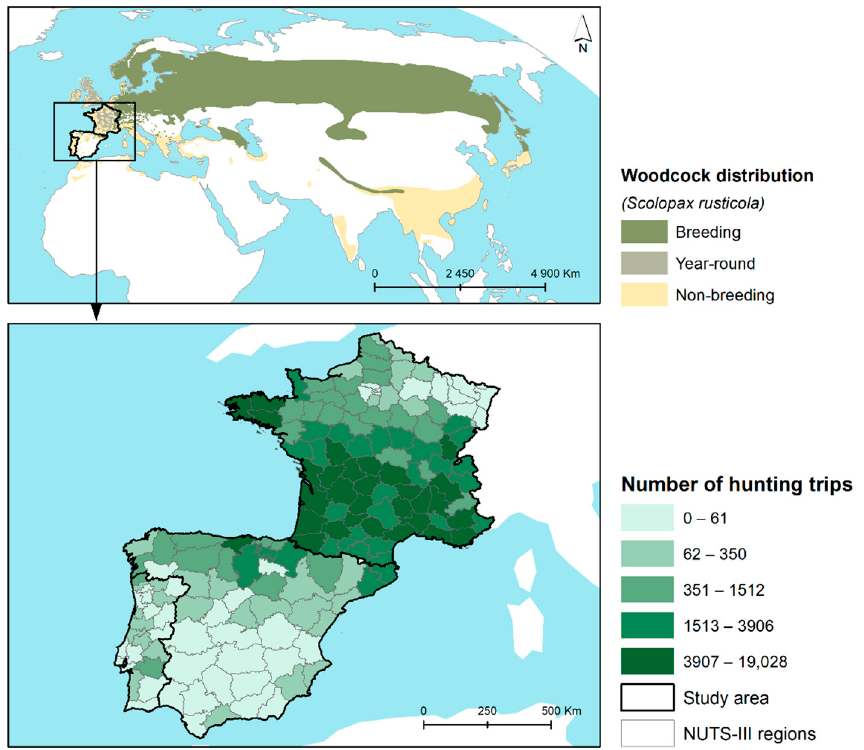
Figure 1. Woodcock ( Scolopax rusticola ) distribution and study area. Distribution: map adapted from [44]; study area (Portugal, Spain, and France) delimited by the black line. In each country, the respective regions of the Nomenclature of Territorial Units for Statistics of level 3 of 2016, NUTS-III (data adapted from [45] are delimited) and spatial variation (by NUTS-III) of the number of Woodcock hunting trips analyzed, carried out by hunters (during the respective hunting seasons, between 2009 and 2018), are represented in five classes by the number quantiles of journeys, i.e., each class represents 20% of the total number of observations. NUTS-III white color—no data.